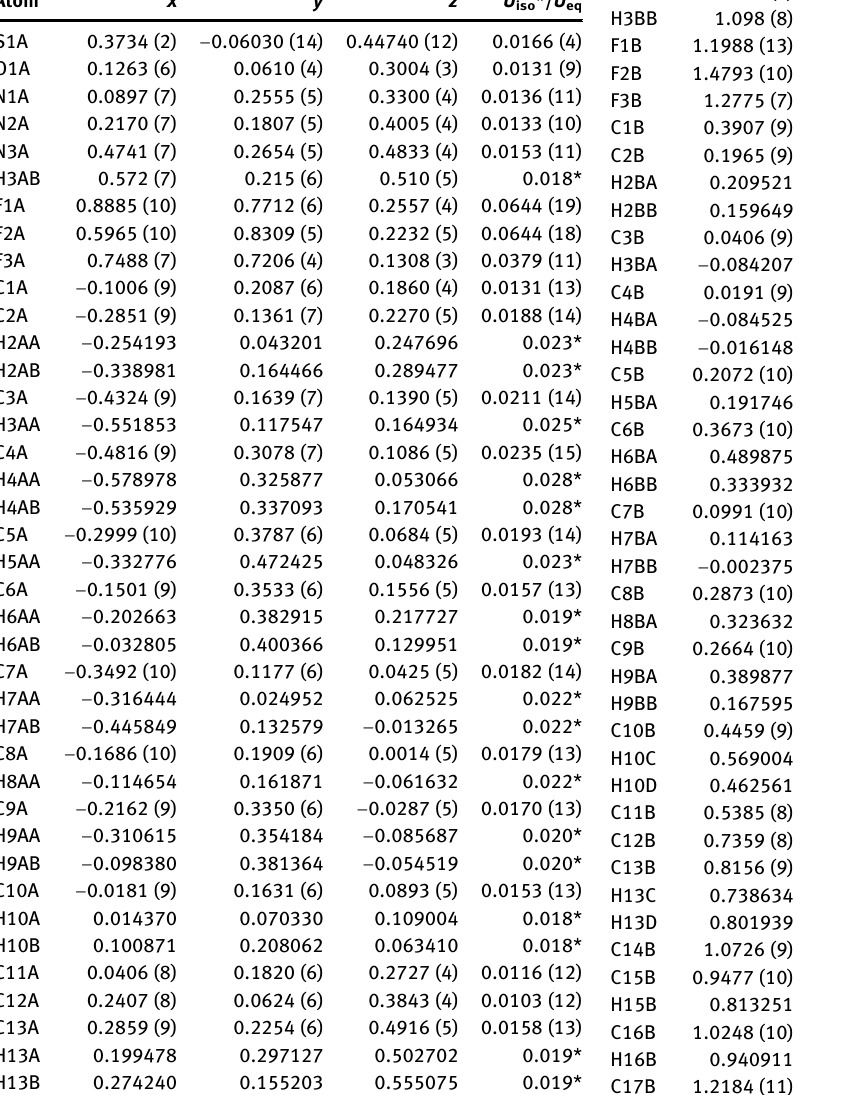
Table  : Fractional atomic coordinates and isotropic or equivalent isotropic displacement parameters (Å 